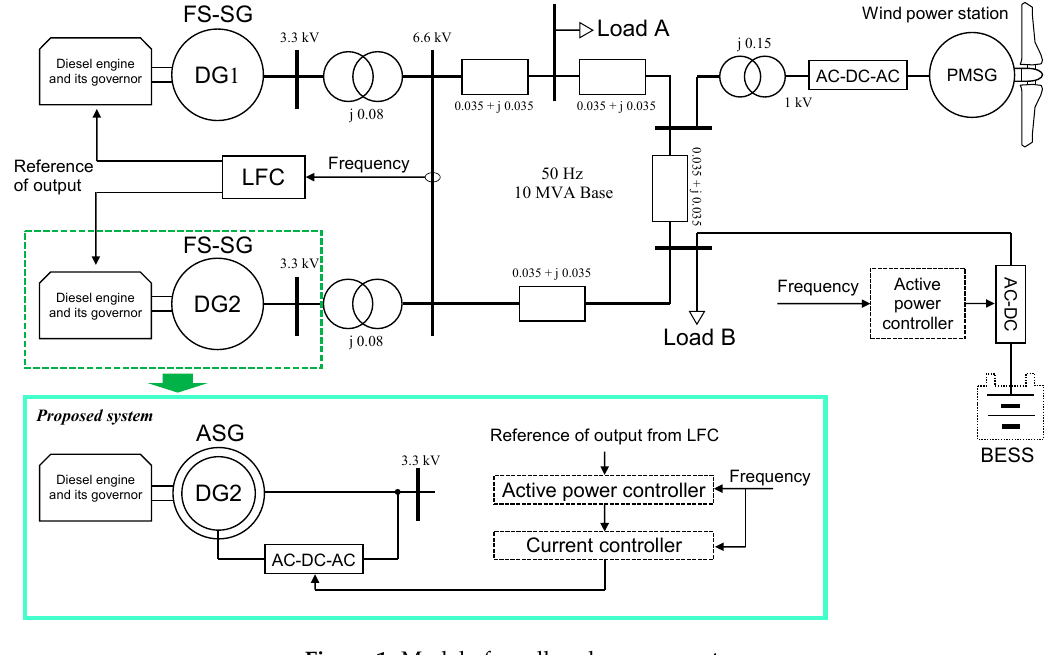
Figure 1. Model of small-scale power system. Table 1. Parameters of power plant and loads.